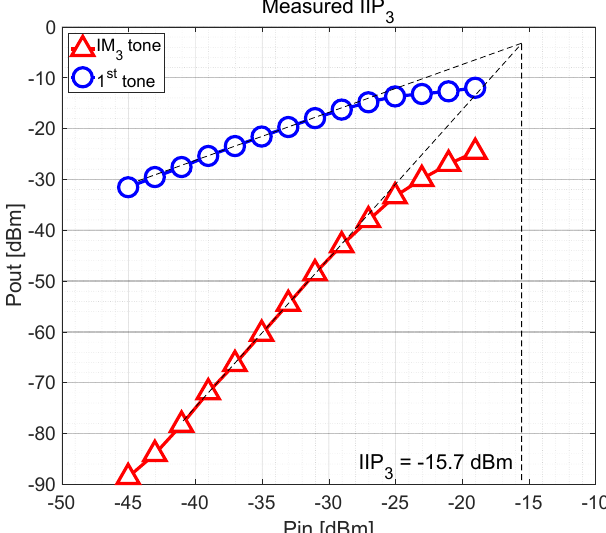
Figure 19. Measure third-order input intercept point.